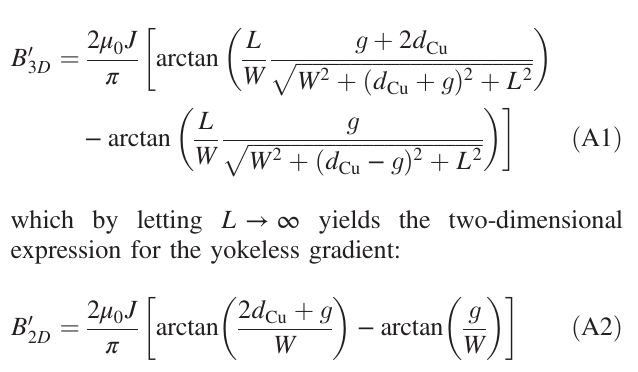
FIG. 11. RADIA simulations showing the maximum gradient of ¼ 5 μ m and d ¼ 300 μ the MPQ with d Si yk